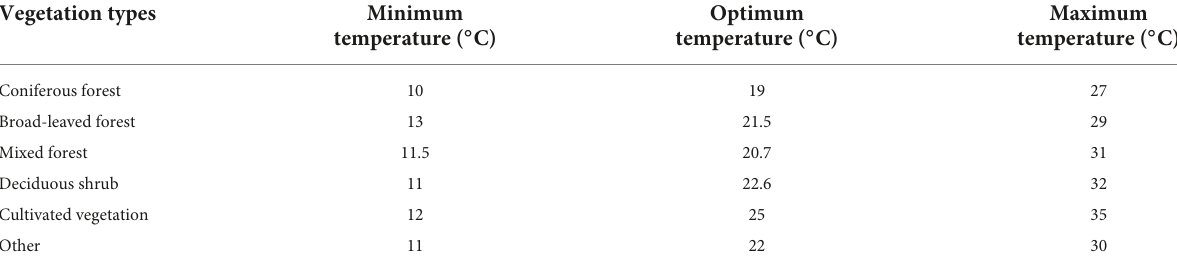
TABLE 2 Three benchmark temperatures for the main vegetation in the study